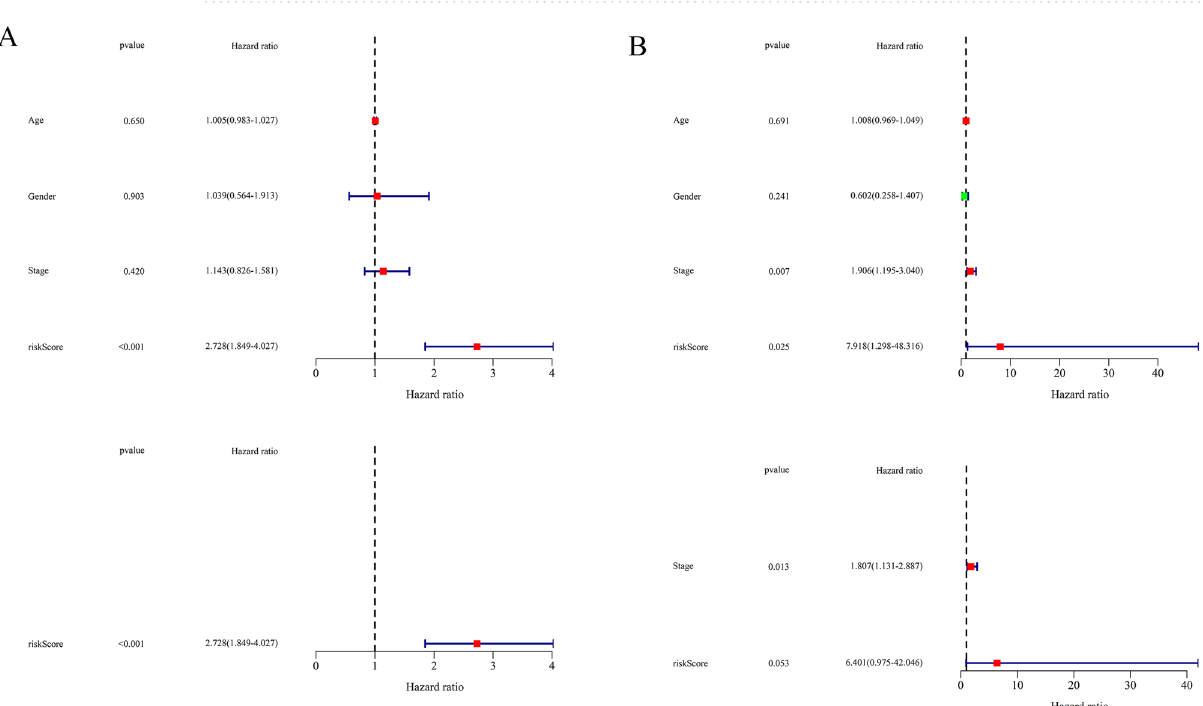
Figure 5. Independent prognostic analysis of risk scores and clinical parameters. ( A,B ) The univariate and multivariate Cox regression analyses of the associations between the risk scores and clinical parameters and the OS of patients in the TCGA ( A ) and ICGC ( B )